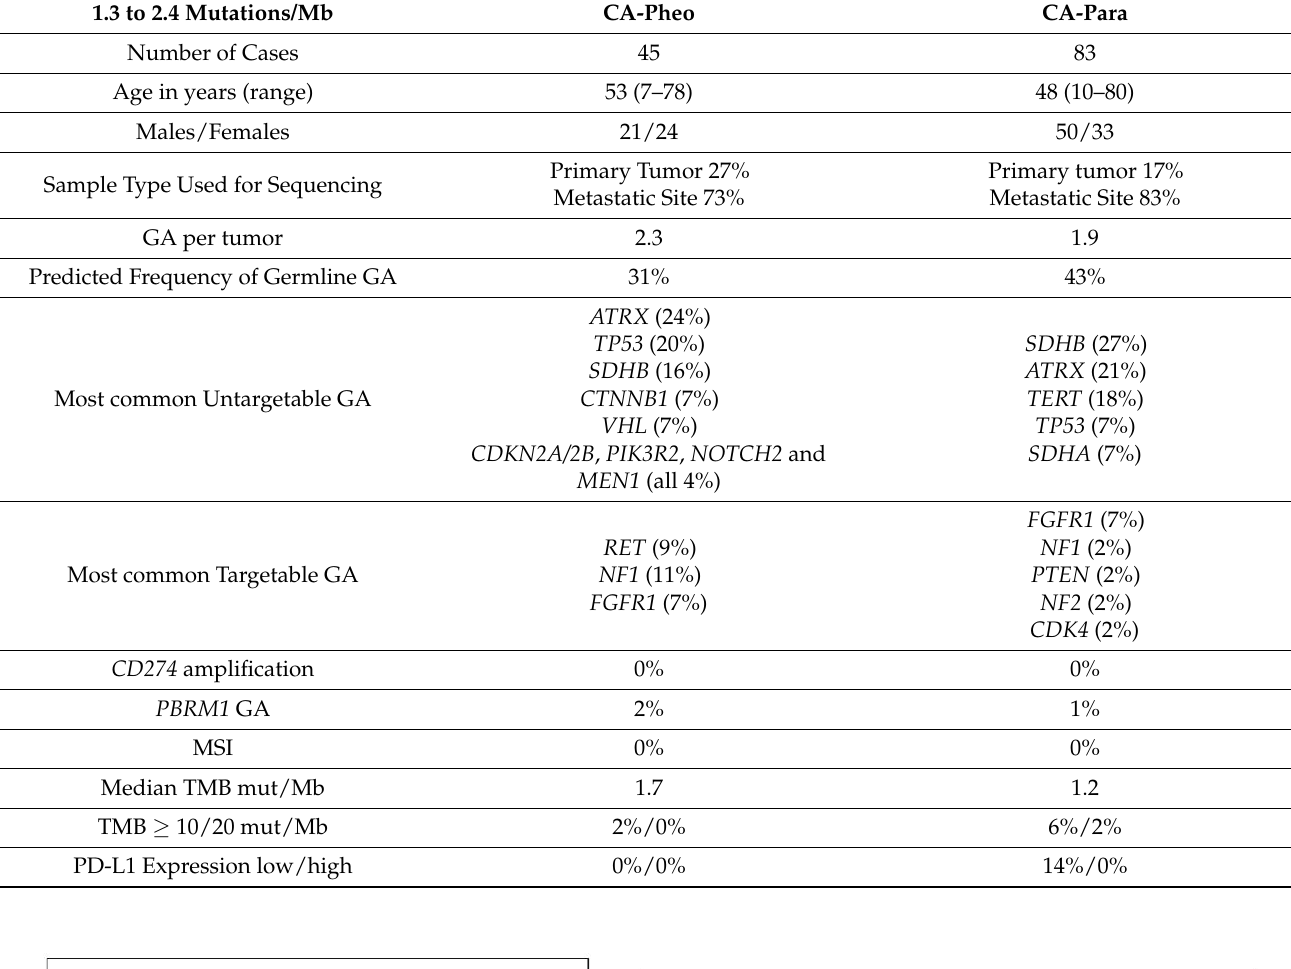
Table 1. Clinical and Genomic Findings in clinically advanced Pheochromocytomas and Paragangliomas.